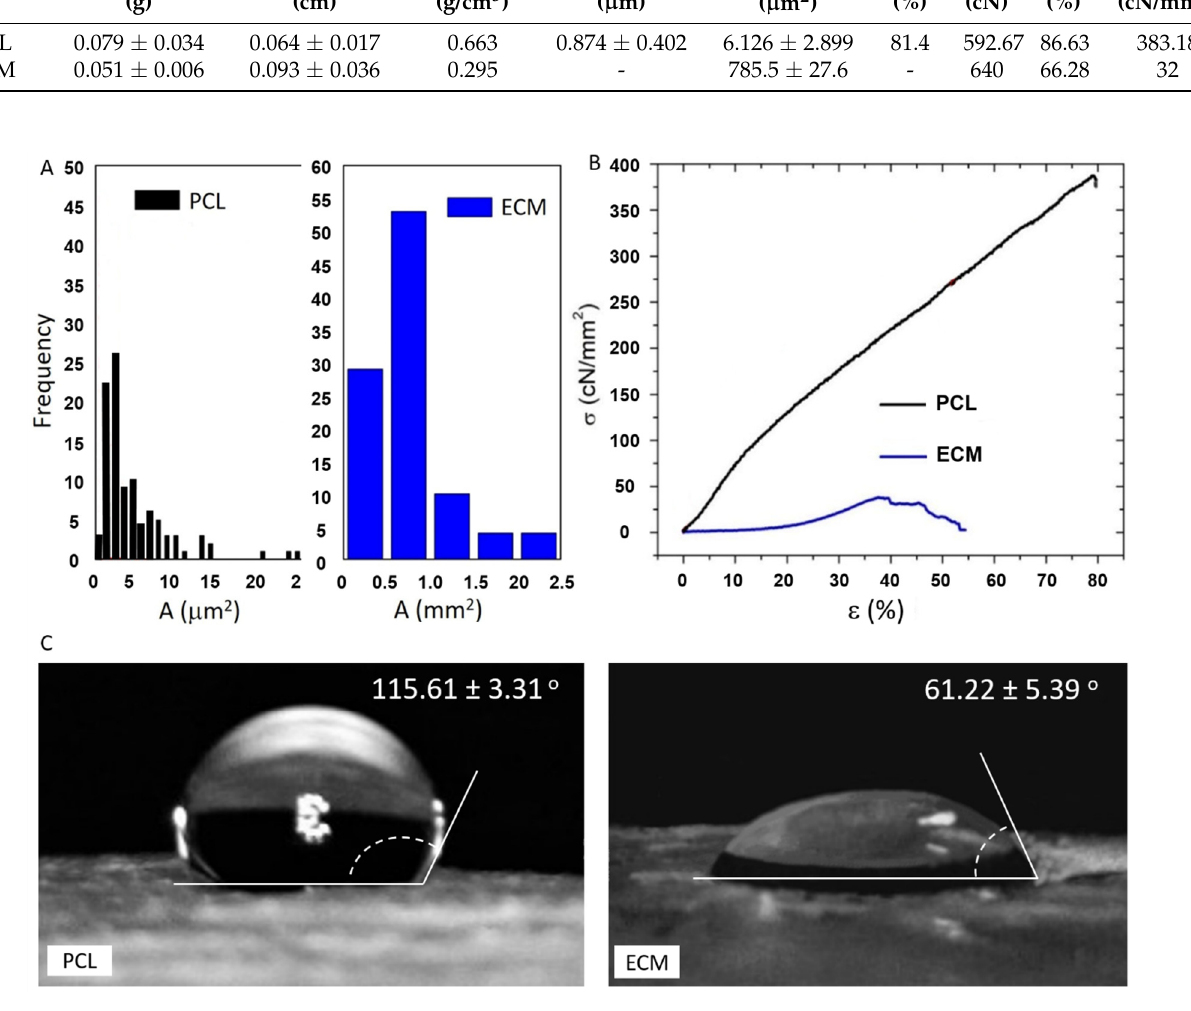
Figure 2. ( A ) Pore area distribution in the electrospun PCL mats and porcine ECM used as cell attachment scaffolds; ( B ) stress curves of tensile strength tested PCL mats and porcine ECM ( σ -tensile strength, ε -strain); ( C ) checking the wettability by letting droplets of water for 30 s on the scaffold surface.